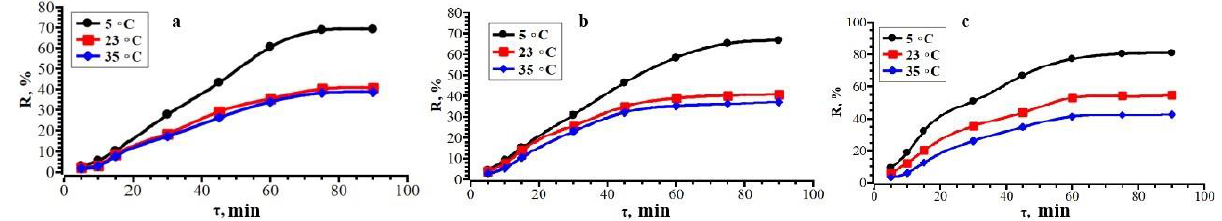
Figure 7. The dependence of the degree of extraction on the contact time for CZO ( a ), CTX ( b ) and CTX ( c ).